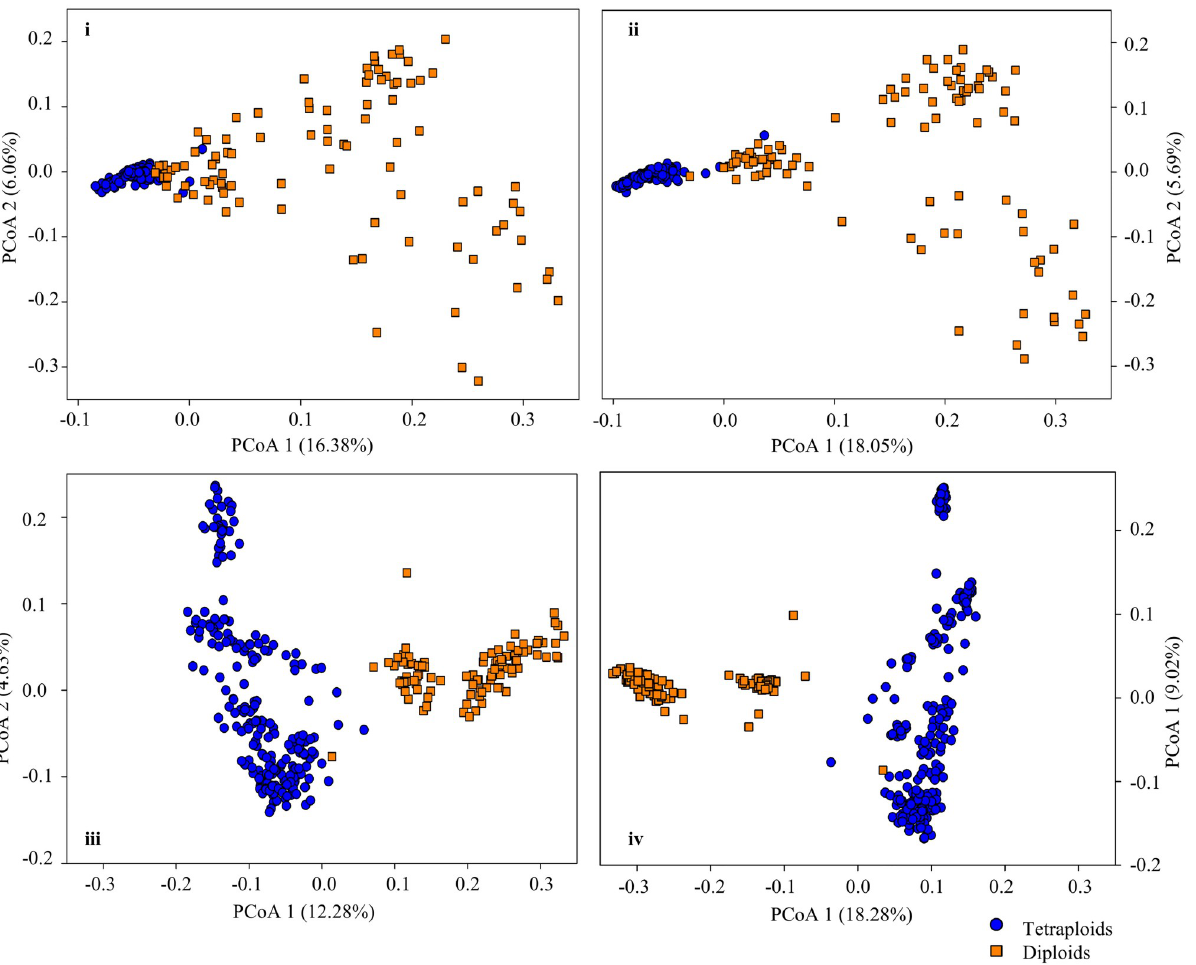
Fig 1. Genetic associations of diploid and tetraploid crested wheatgrass genotypes used for the genomic selection study as explained by PCoA1 and PCoA2 of principal coordinate analysis. (i) SNPs at 20% missing level; (ii) SNPs at 30% missing level; (iii) SNPs at 40% missing level; and (iv) SNPs at 50% missing